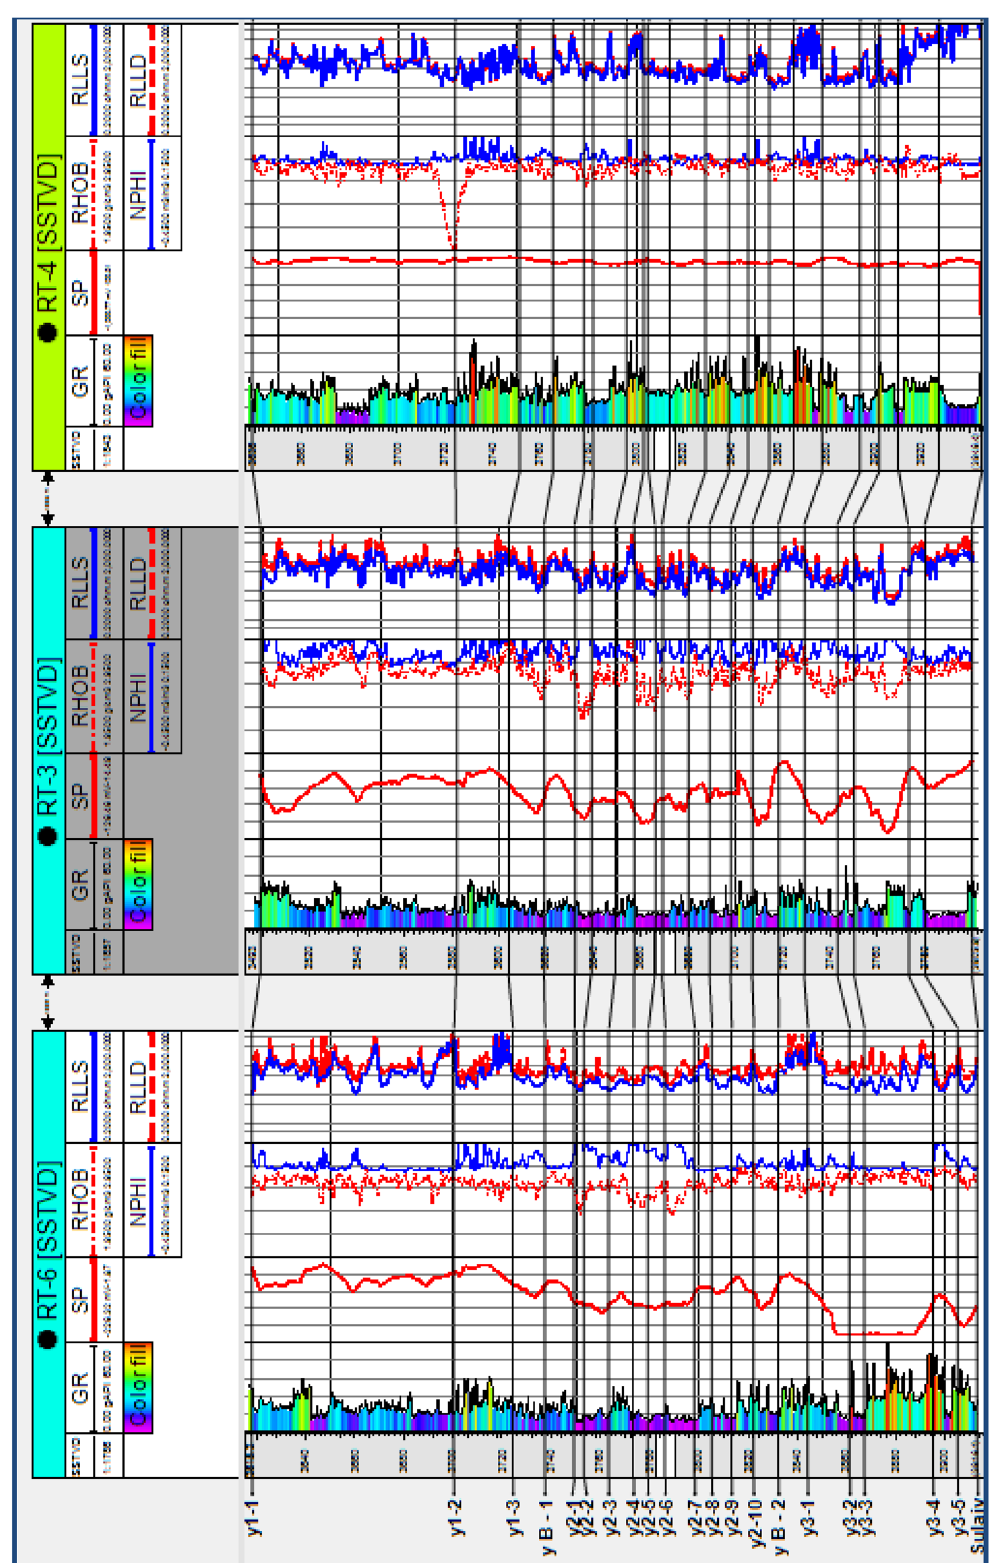
Fig. 6 Well logs section for wells Rt-6, 3, and 4 in Yamama